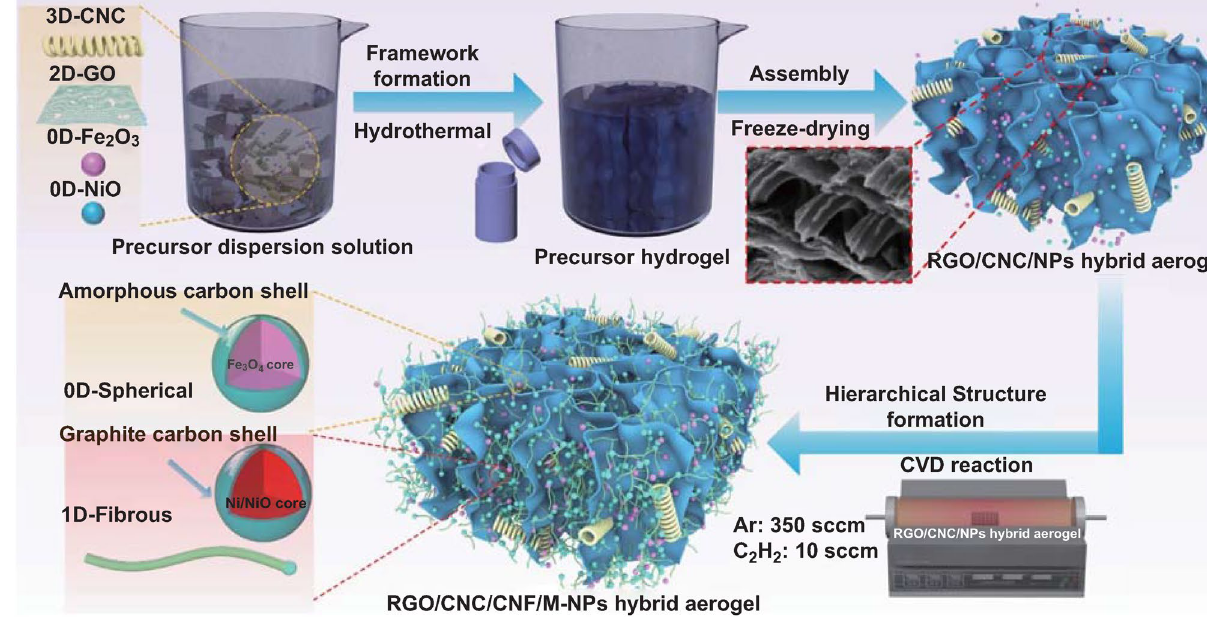
Fig. 1 Overall synthesis procedure of the RGO/CNC/CNF/M-NPs hierarchical